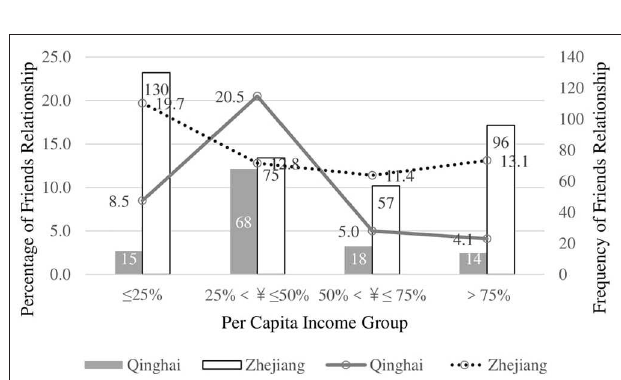
FIGURE 1 | Interaction between ethnics and income for Friends relationship with doctors in Primary Care Institution in Qinghai Province.